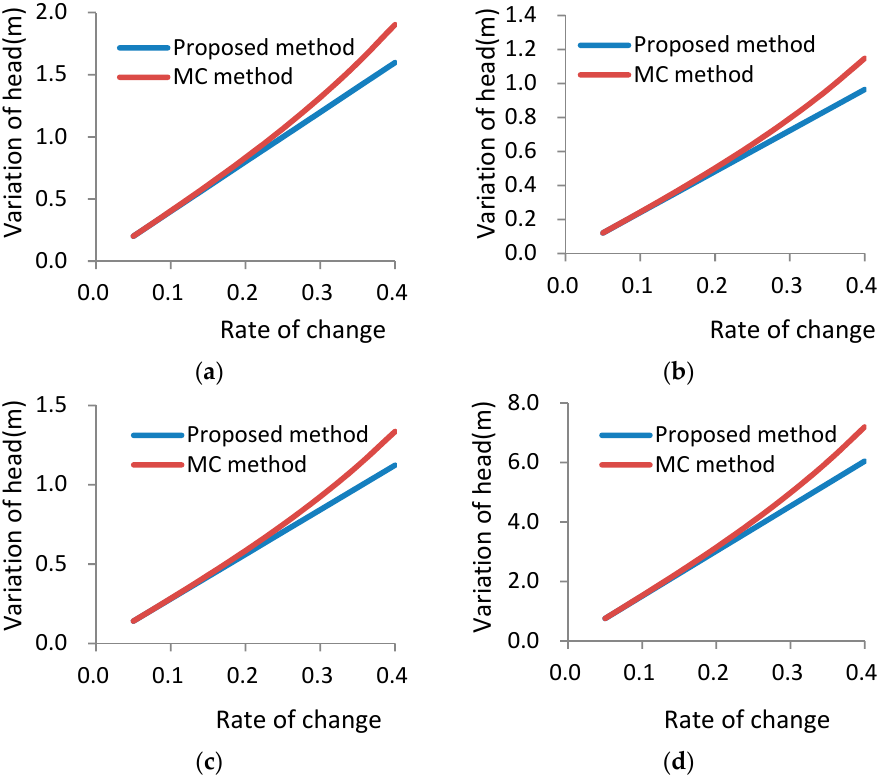
Figure 2. Comparison of two methods in Scenario One (( a ) observation well 2; ( b ) observation well 3;